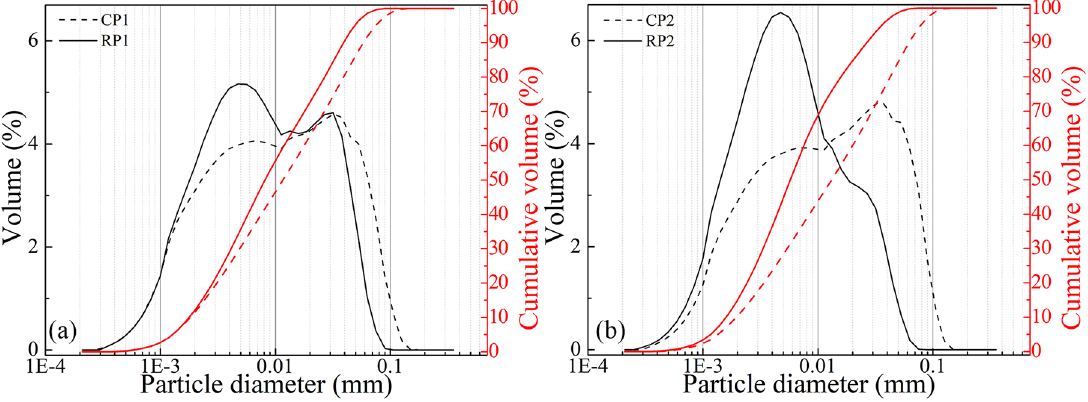
Figure 4. Particle size distribution of samples (a) CP1 and RP1 and (b) CP2 and RP2. Table 4. Values of average diameter ( D commercial and recycled plasters.